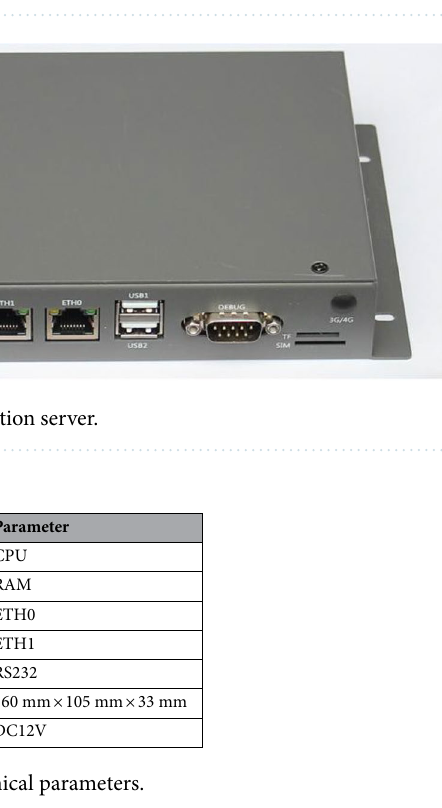
Figure 5. Block diagram of the hardware structure of the RFID inspection system.